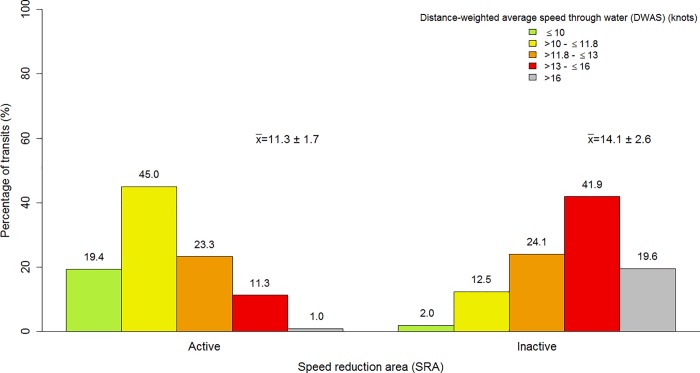
Histograms of transits distance-weighted average speed in the speed reduction area when the voluntary measures were active (left panel) and inactive (right panel) for the 2012–2016 period. The difference between these distributions is statistically significant (Kolmogorov-Smirnov test, D = 0.538, p-value < 0.001). The 11.8 knot threshold corresponds to a 50% probability of lethal injury in case of a collision [16].